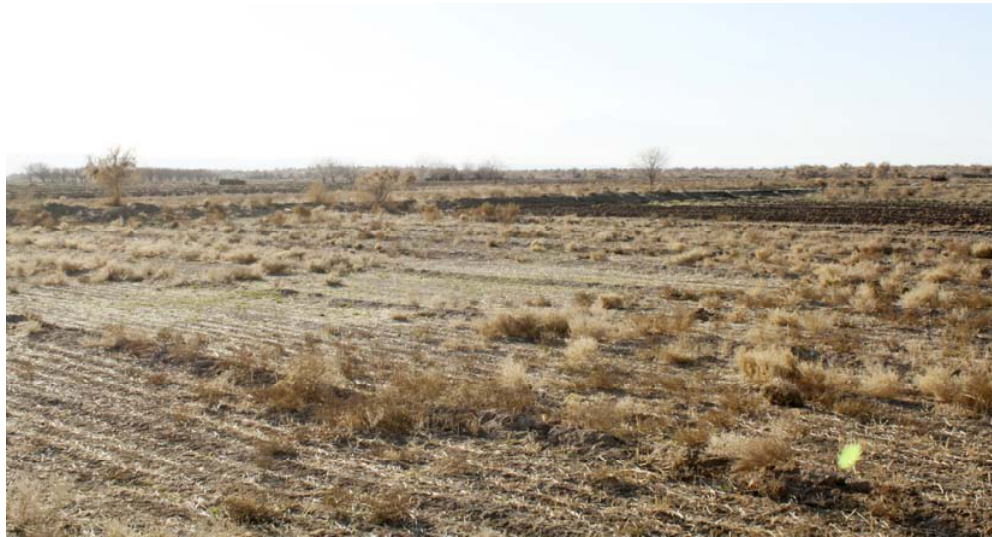
F IGURE 3 . Habitat of Ophiomorus maranjabensis (the specimen